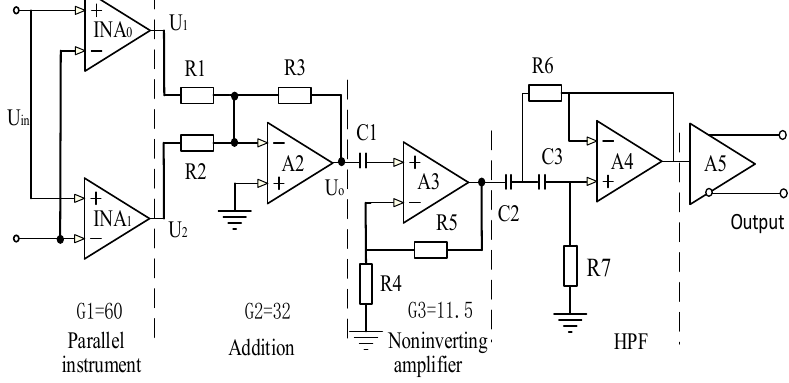
Figure 3. Schematic of the low-noise amplifier.